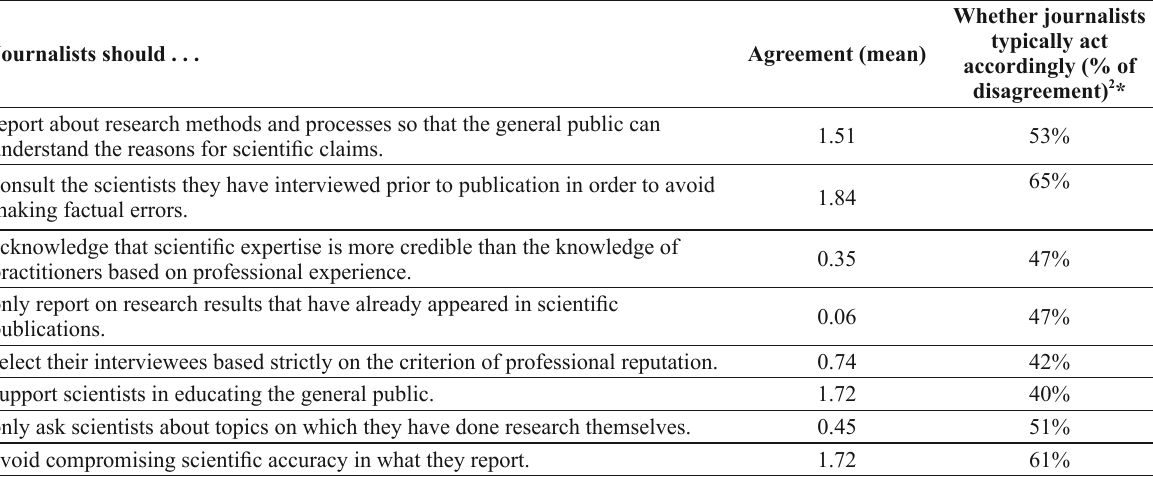
Level of agreement on how scientists should act with media contacts, how journalists should report on science, and whether journalists typically act accordingly*. Journalists should . .